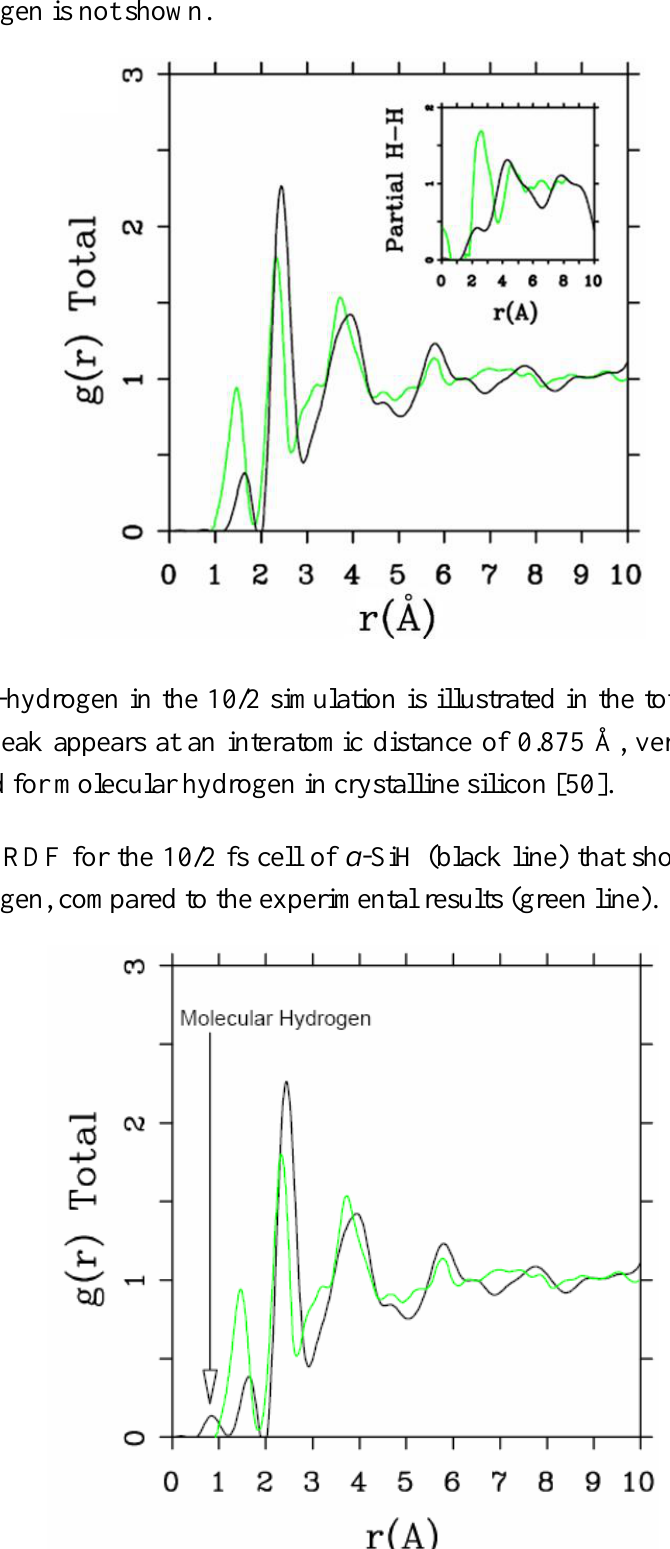
Figure 3. Direct comparison of the simulated total RDF and H–H pRDF (Inset) for a -SiH (black lines) to the experimental results (green lines) for the 10/2 fs cell. The peak due to molecular hydrogen is not shown.